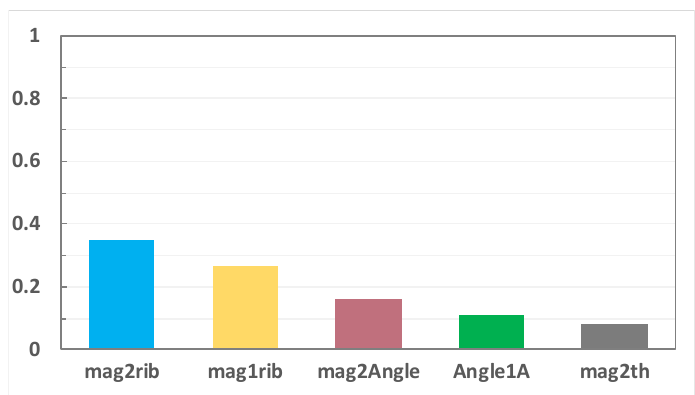
Figure 11. Torque ripple-optimal factor contribution.